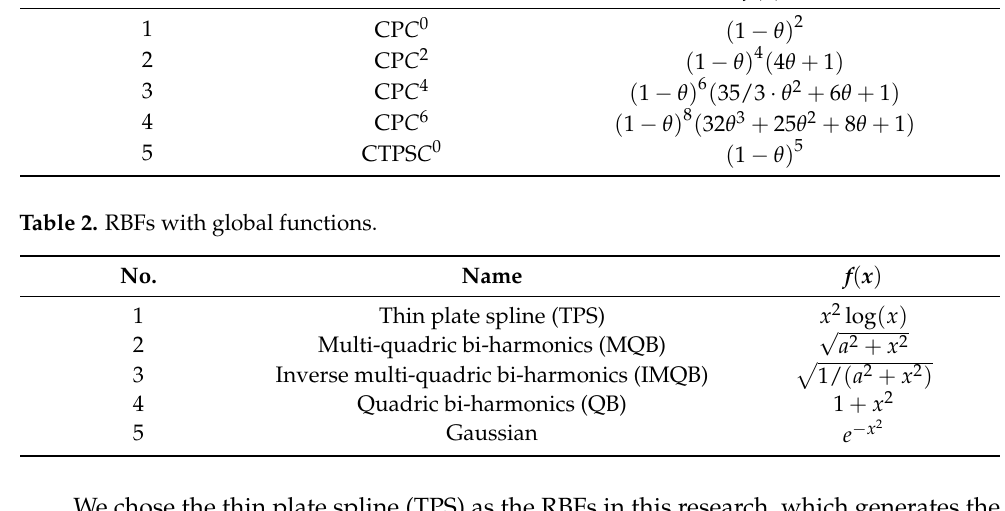
, x is the Euclidean distance r